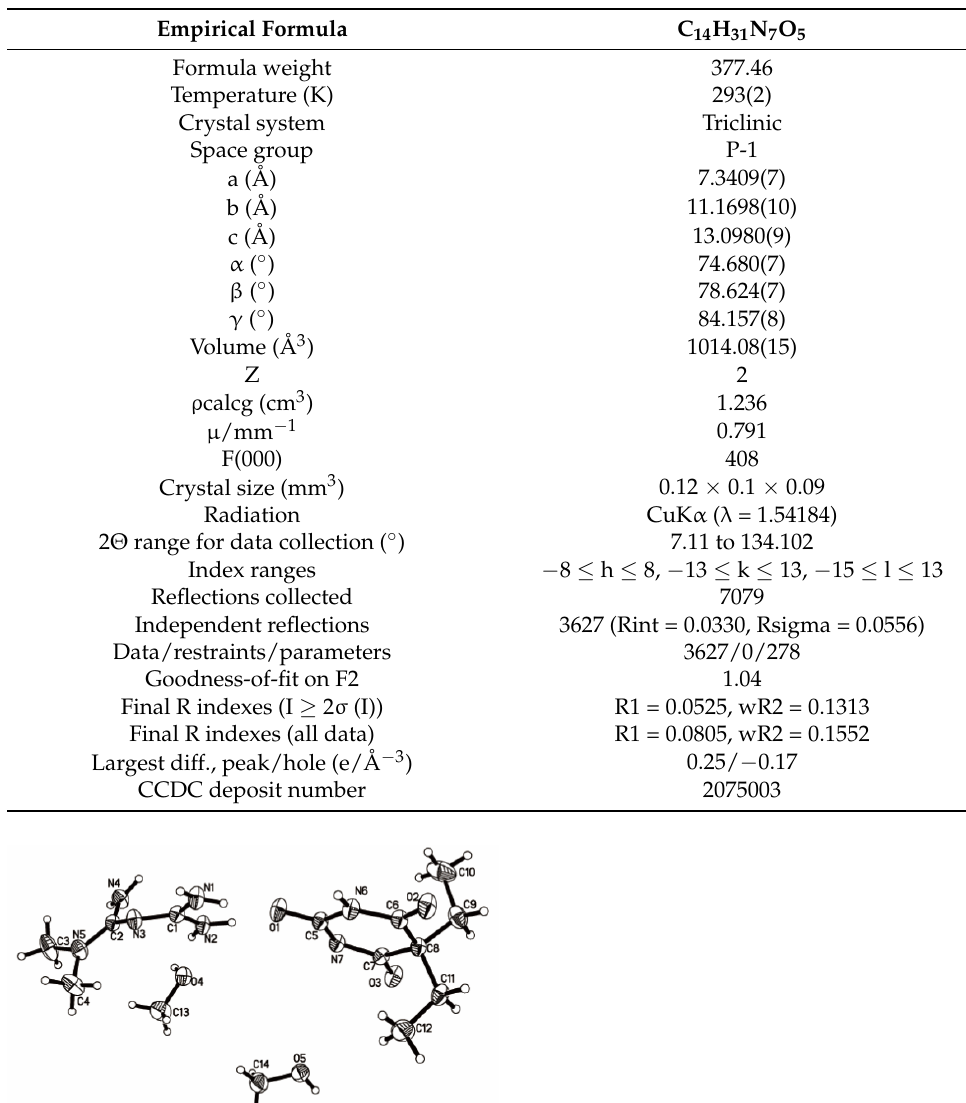
Table 1. Crystal data and structure refinement for Met–Bar.